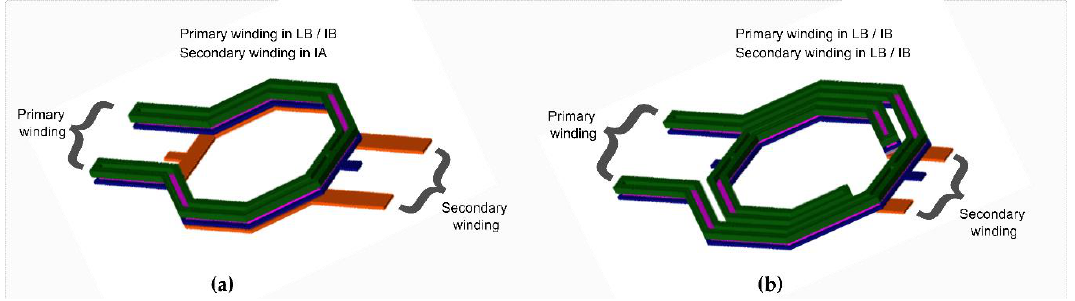
Figure 3. 3D view of integrated transformers in 28-nm CMOS technology: ( a ) stacked; ( b ) interleaved.